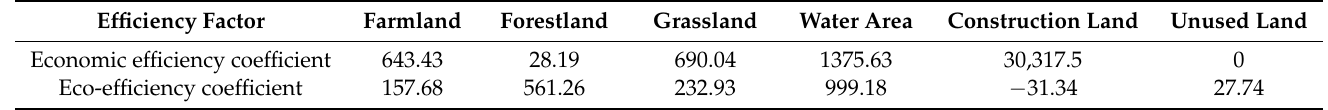
Table 2. Economic eco-efficiency coefficients per unit area (10 4 Yuan/km 2